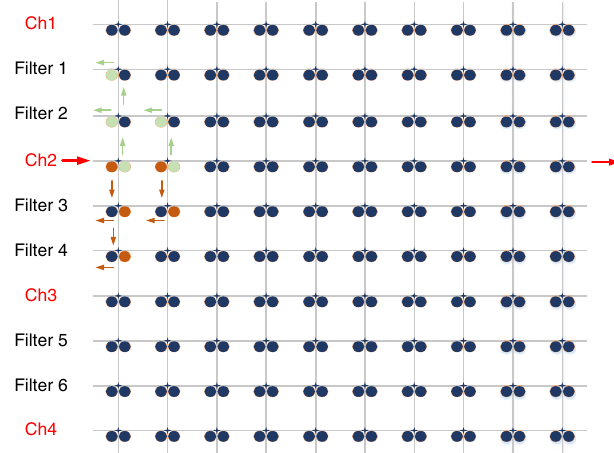
Fig. 6 A 10 × 10 signal processor layout. When this processor is operating as an optical beamforming network, four channels are used as beam steering channels and six channels as fi lter channels to eliminate crosstalk.